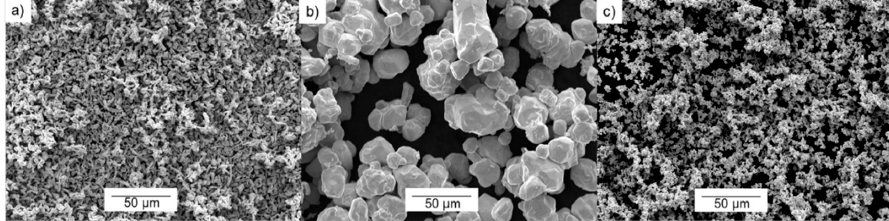
Figure 1. Secondary Electron-SEM images of the starting powders: ( a ) Cu powder; ( b ) Coarse W powder (W c ); ( c ) Fine W powder (W f ).